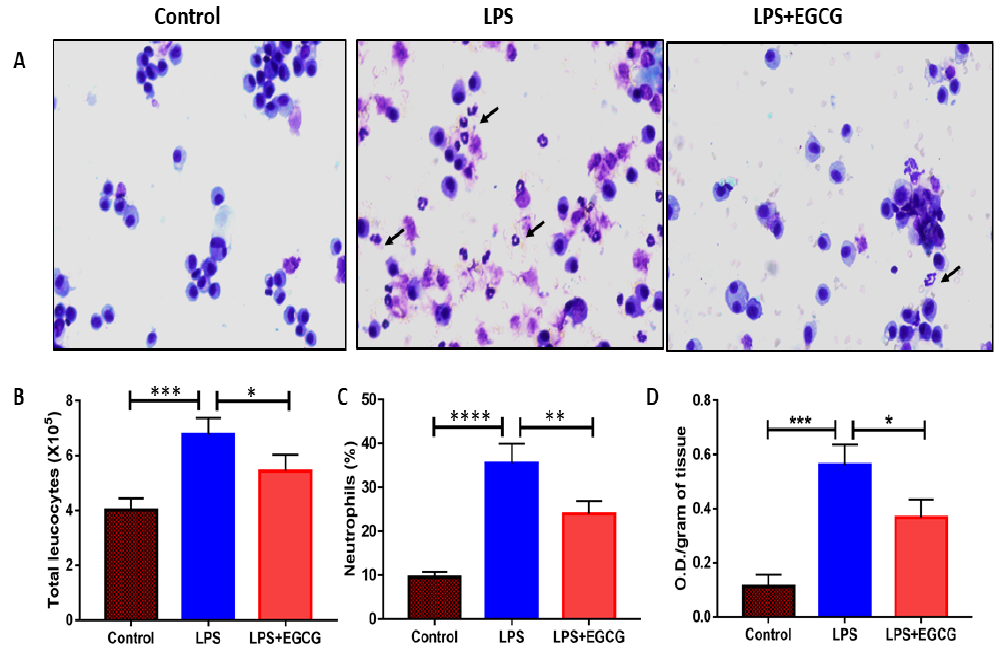
Figure 2. Effects of EGCG on total leukocyte count, and neutrophil differential count and myeloperoxidase (MPO) activity in the BAL of LPS-induced ALI mice. Total BAL fluid was collected after 18 h of ALI instillation from different groups. ( A ) Representative slides show infiltrated cells, cytospin was performed and stained with HEMA of different groups. Enhanced polymorphonuclear neutrophils in the cytospin slides of the LPS-instilled group with control and EGCG treatment groups. ( B ) The LPS group showed a significant increase in the TLC compared with the control and the treatment with EGCG reversed this effect. ( C ) The neutrophil cells percent had a significant enhancement in the LPS(IT) group compared with the control group and the EGCG treatment reduced significantly the percent of neutrophils. ( D ) The lung MPO activity showed a significant rise in the LPS-instilled group compared with the control group and the EGCG administration reduced LPS-induced BAL MPO levels. Significant difference * p < 0.05 and *** p < 0.001. Data represent the mean ± SEM ( n = 4 animals per group).